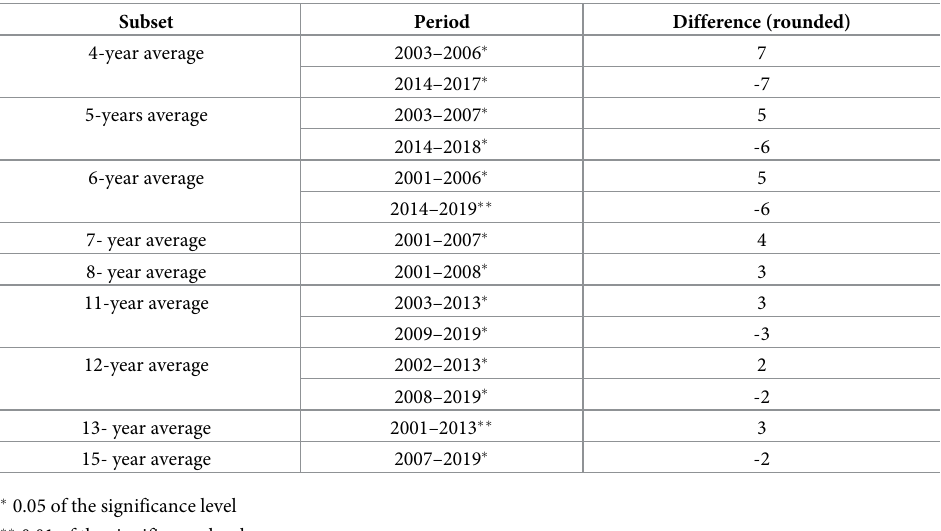
Table 2. Differences between the mean start of the subsets and the overall average.